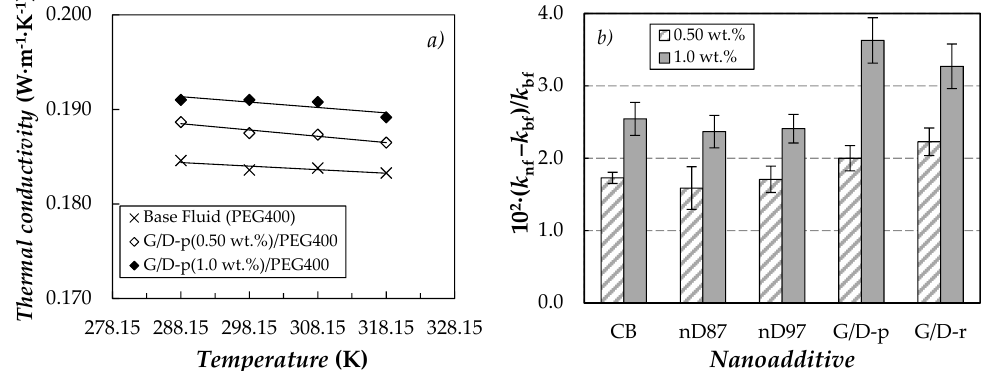
Figure 7. ( a ) Temperature dependence of thermal conductivity for (G / D-p) / PEG400 nanofluid system. ( b ) Average thermal conductivity enhancements regarding base PEG400, 10 2 ·( k nf − k bf )/ k nf . Error bars represent the standard deviation between values obtained for the different studied temperatures.